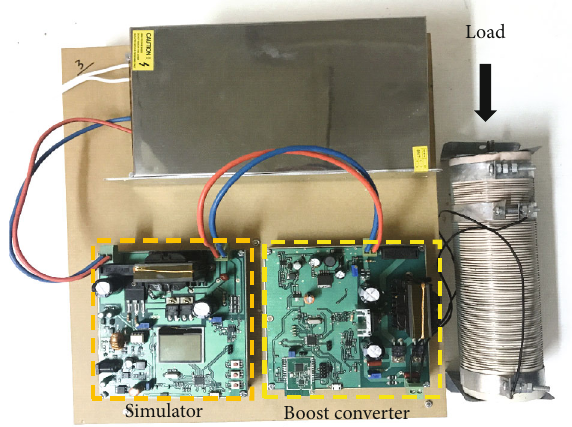
Figure 17: The set of converter and